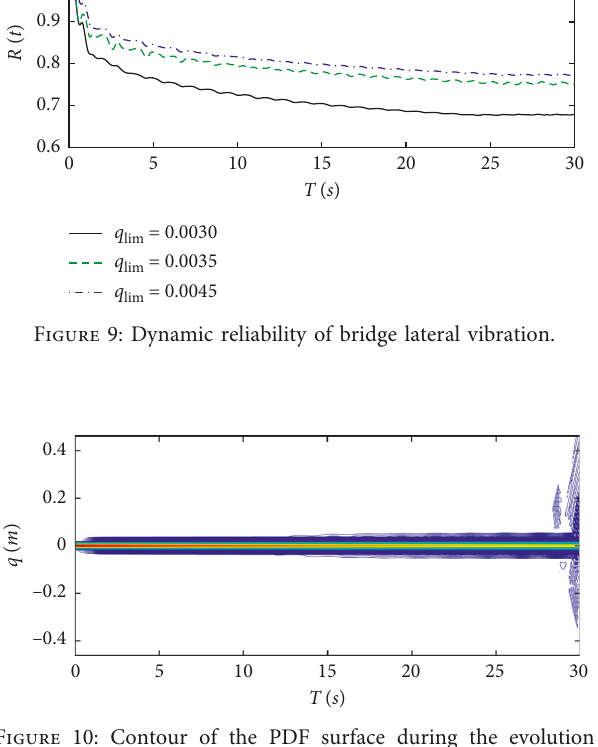
Figure 10: Contour of the PDF surface during the evolution 180). process ( N p (cid:31)